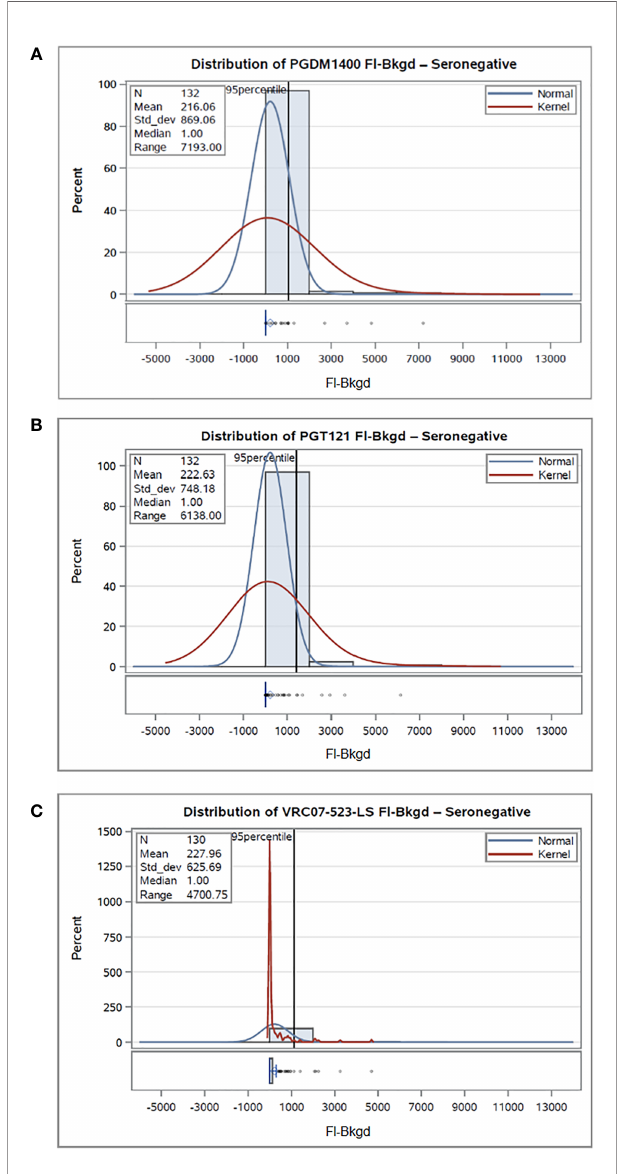
FIGURE 2 | Non-speci fi c background activity of HIV-1 seronegative human serum. 132 HIV-1 seronegative samples were tested at 1:100 in the PGDM1400/PGT121/VRC07-523-LS PK BAMA, and the distribution of binding to the PGDM1400 anti-ID (A) , PGT121 anti-ID (B) , and VRC07-523- LS anti-ID (C) was plotted. Normal and kernel density estimates are used to visualize the data distribution. Normal shows the fi t of a normal distribution to the FI-Bkgd measurements, and a superimposed fi tted density curve on the histogram. Kernel density estimates on histograms help smoothen the data distribution and help visualize the non-normal data distribution and patterns.